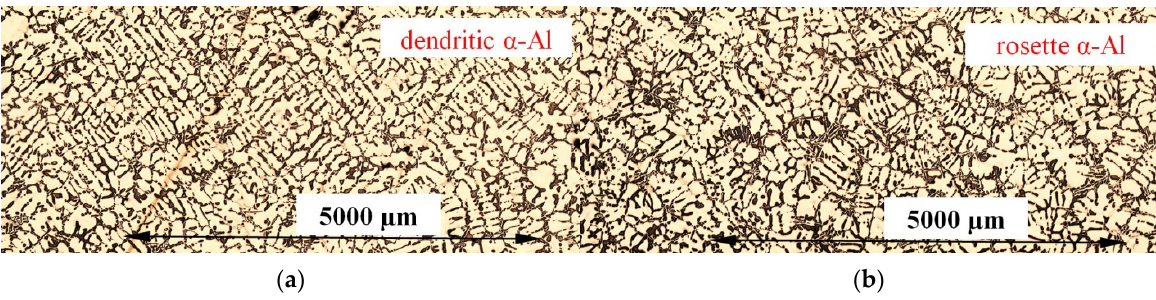
Figure 5. Microstructures of the AlCu4Si6Mn0.65 specimen solidified: ( a ) without and ( b ) with electromagnetic stirring. LOM, magnification 50×.